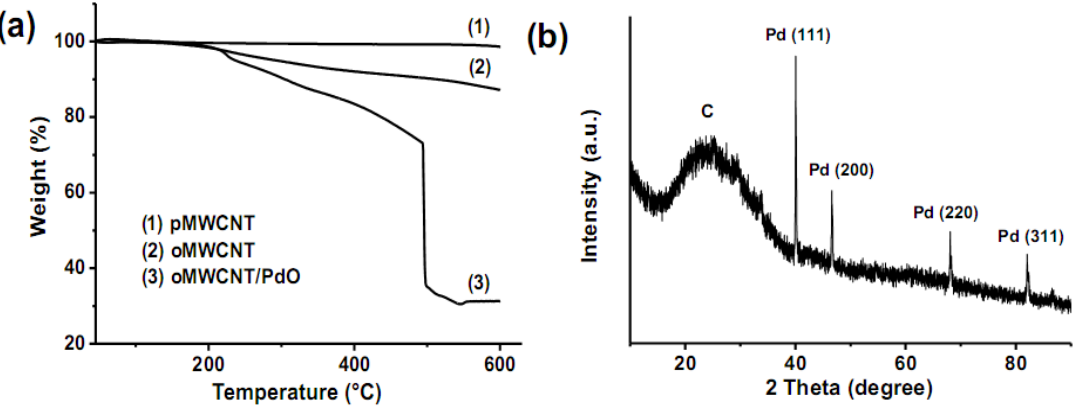
Figure 6. (a) TGA curves of (1) pMWCNTs, (2) oMWCNTs, and (3) oMWCNT/PdO. (b) XRD pattern of the residual powders of oMWCNT/PdO collected after the TGA